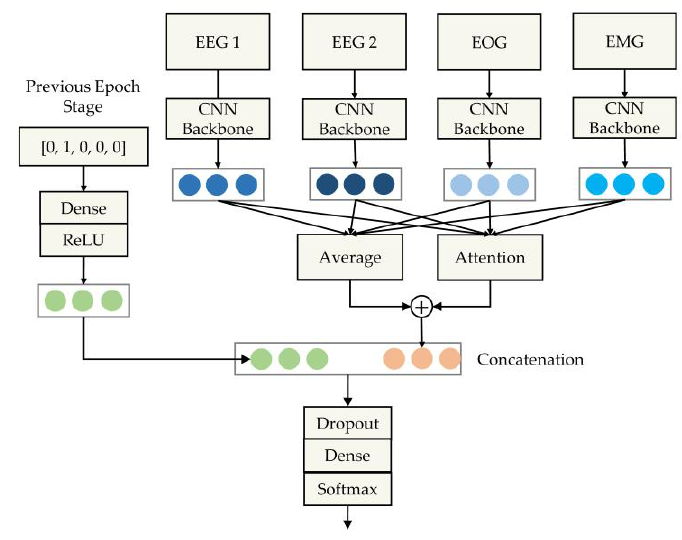
Figure 3. Schematic diagram of the proposed multi-branch convolution neural network combined with embedded stage refinement and residual attention-based channel fusion.